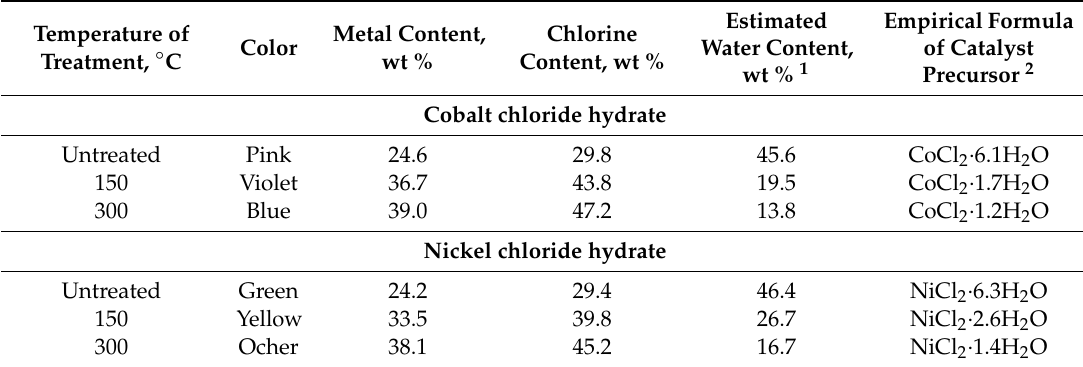
Table 1. Characteristics of the catalyst precursors subjected to a thermal treatment for 4 h under